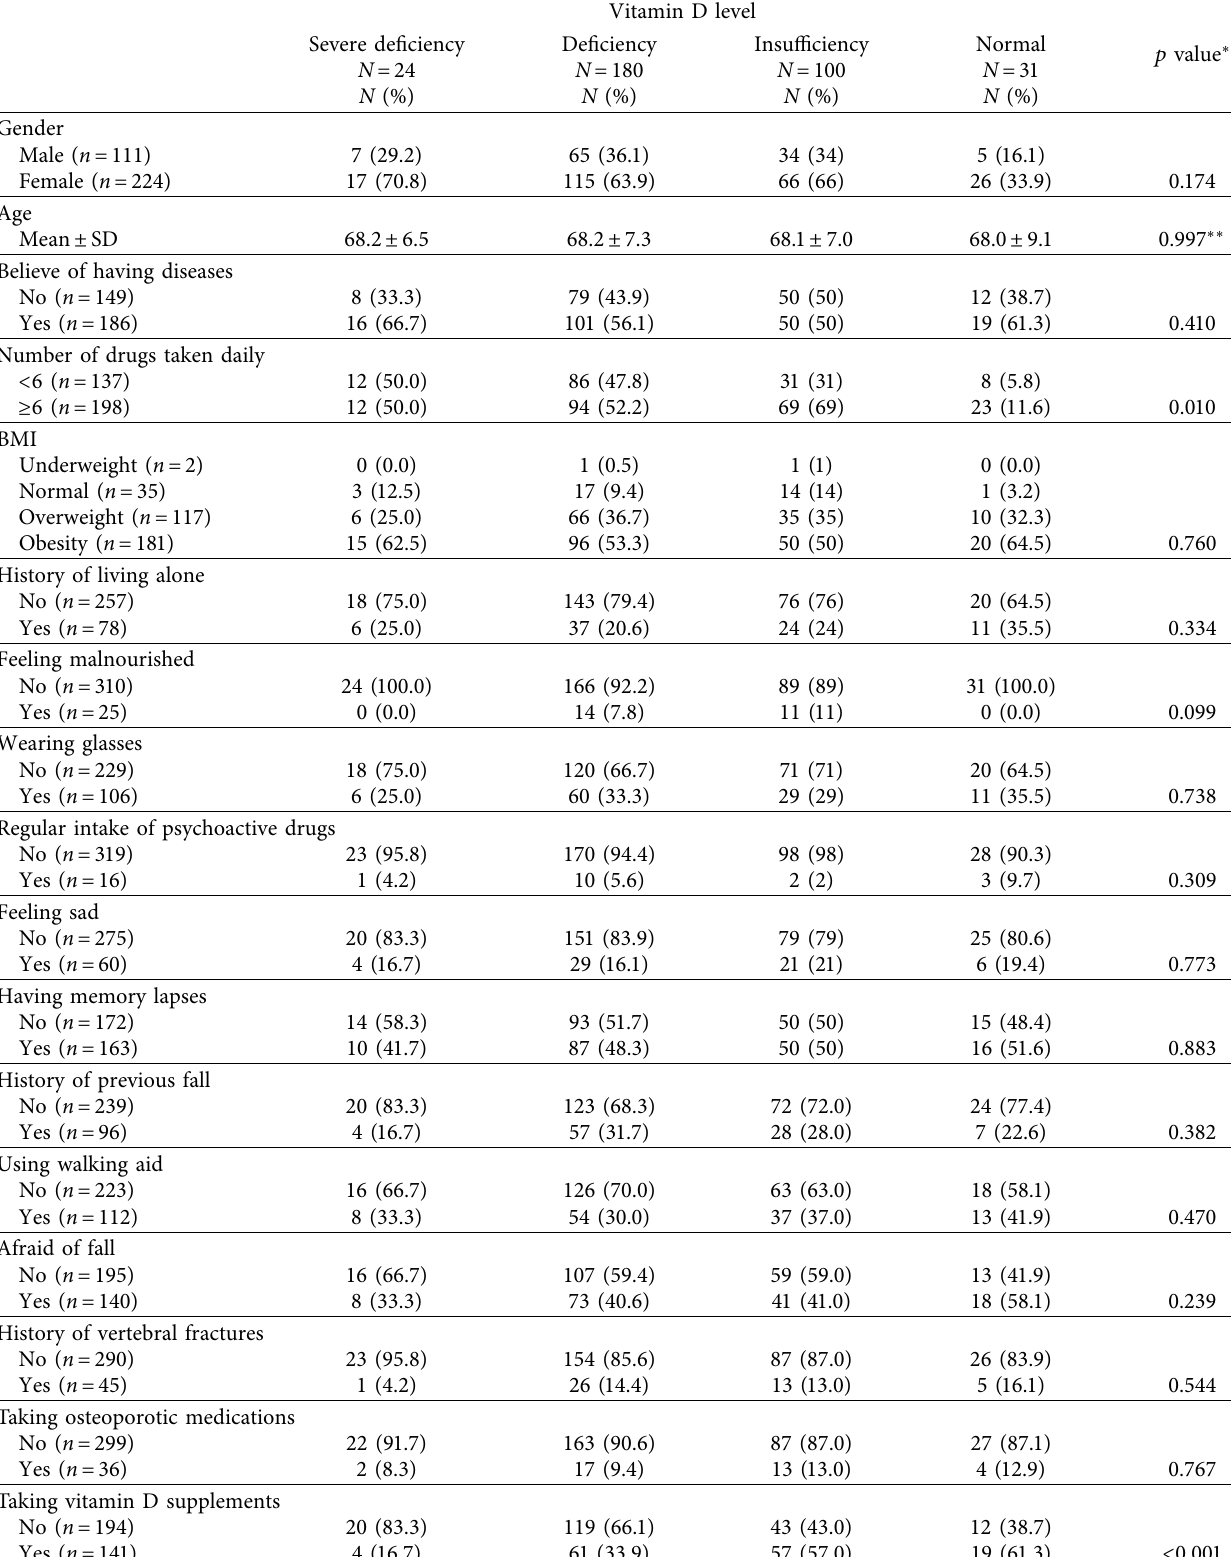
Table 2: Factors associated with vitamin D levels among elderly people, Jeddah. Vitamin D